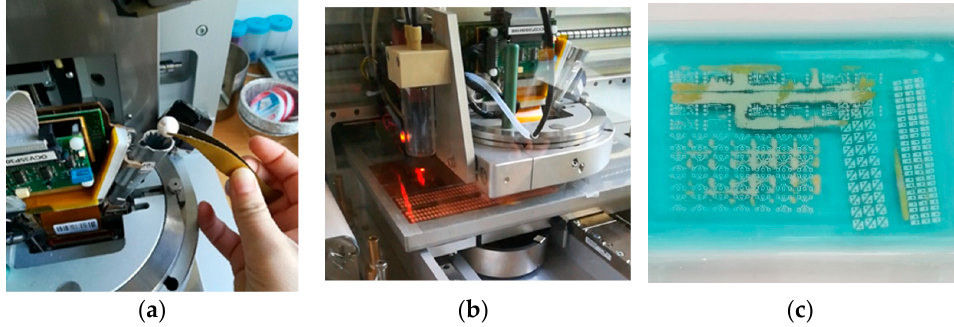
Figure 6. ( a ) Filling the wax and preparing the print of conductor pattern ( b ) Wax printing process ( c ) Etching process.